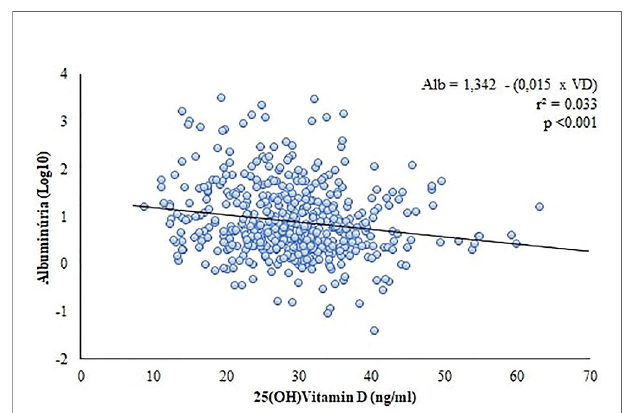
FIGURE 3 | Correlation and linear regression between Vitamin D levels and HbA1c.